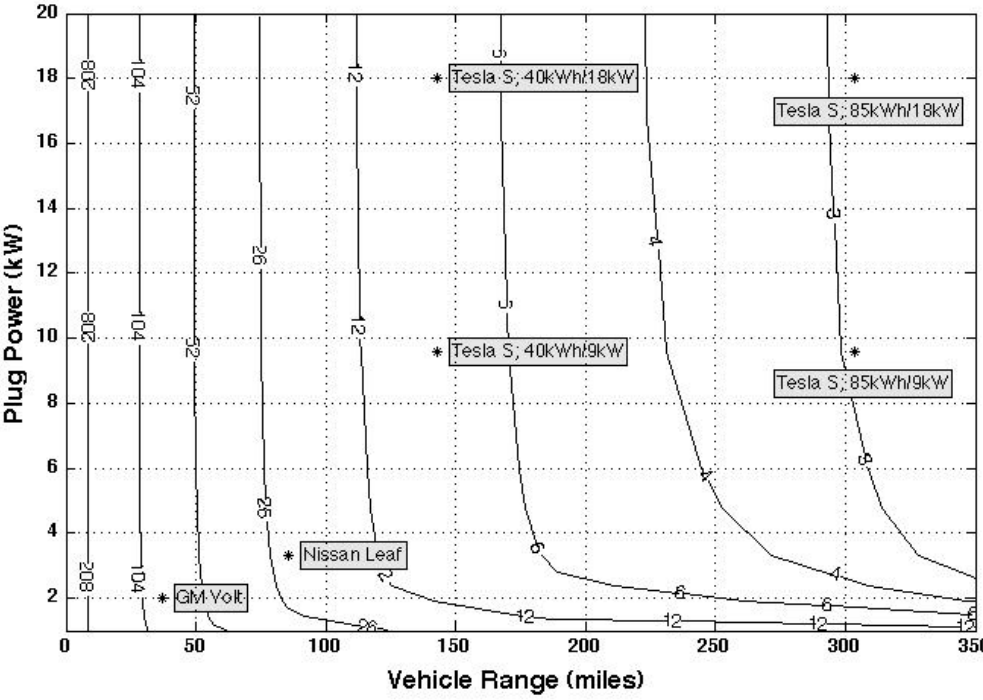
Figure 6. Adaptation days for charging at Home and at Work. Reprinted by permission, from Pierre [24].